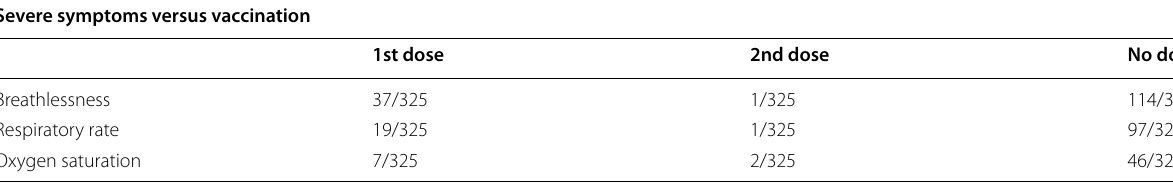
Chi-square test statistics ( p value): 12.21